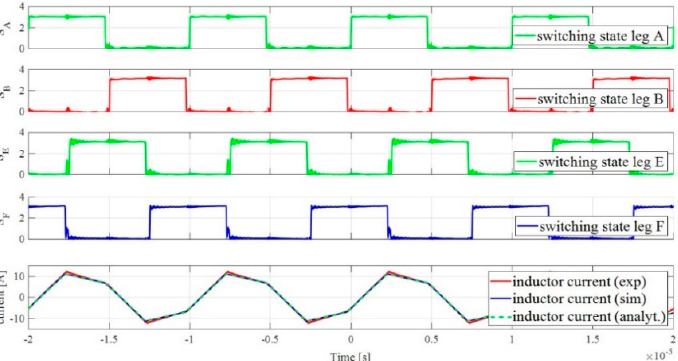
Figure 11. Gate control signals and inductor current matching waveforms for semi-analytical, PLECS simulation and experimental model (case 1).